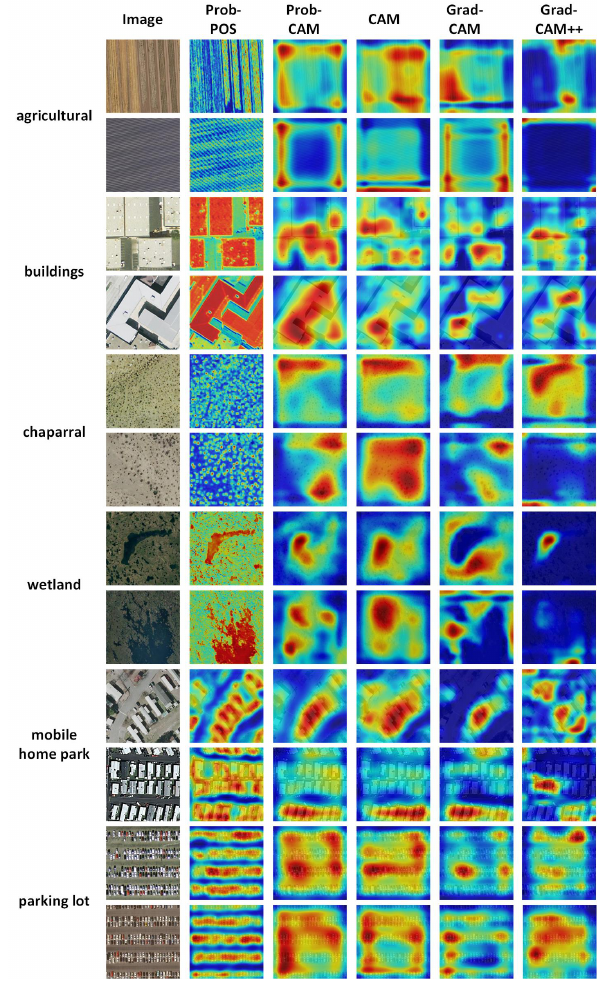
Figure 8. The explanation maps for sampled images from different scene classes generated by Prob- POS, CAM and Grad-CAM. They were obtained on middle or shallow layer, which was the optimal explanation layer for the category